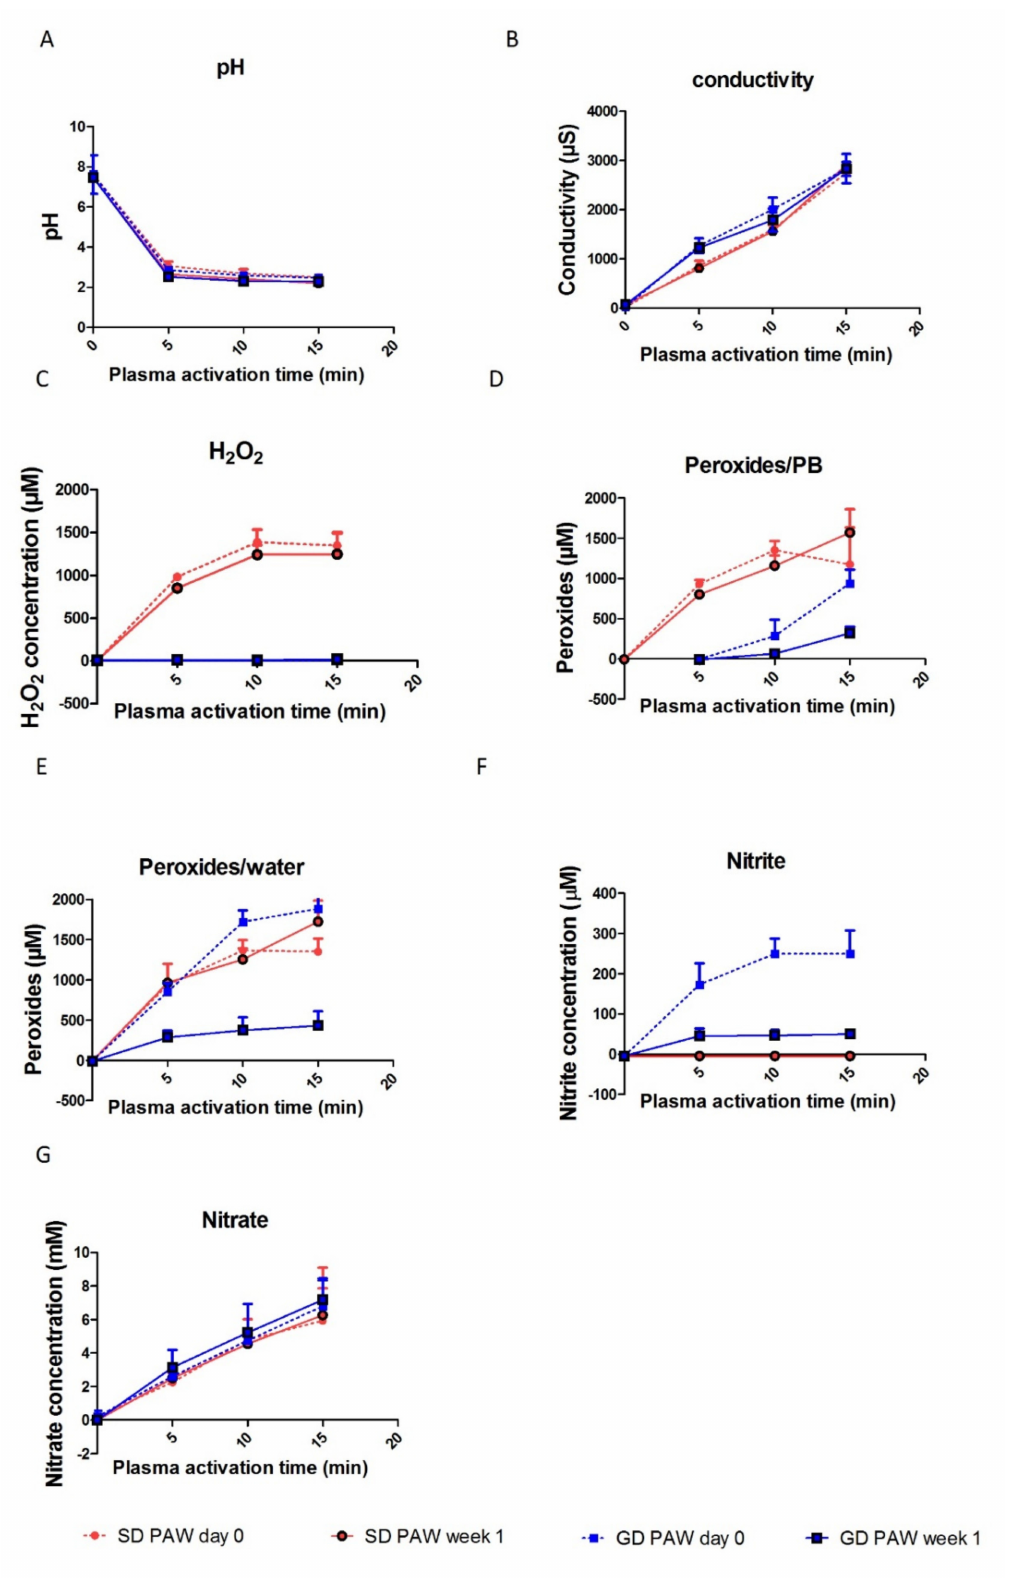
Figure 2. Chemical composition of plasma activated water (PAW) made by spark and glow discharges on the day of generation (Day 0) and after 1 week storage. ( A ) pH; ( B ) conductivity measurements; ( C ) hydrogen peroxide measured by TiOSO 4 ; ( D ) peroxides measured by KI buffered with PB; ( E ) peroxides measured by KI and water; ( F ) nitrite concentration; ( G ) nitrate concentration (data shown as mean ± SD, n = 3 experiments with measurements performed in